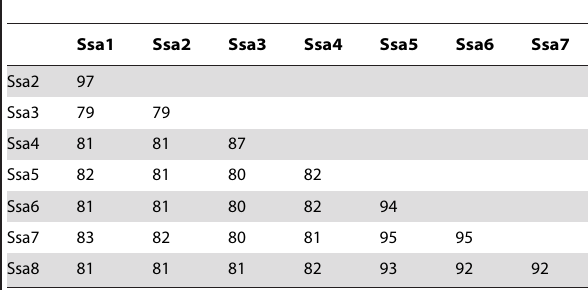
Table 1. Percent amino acid identity of Ssa